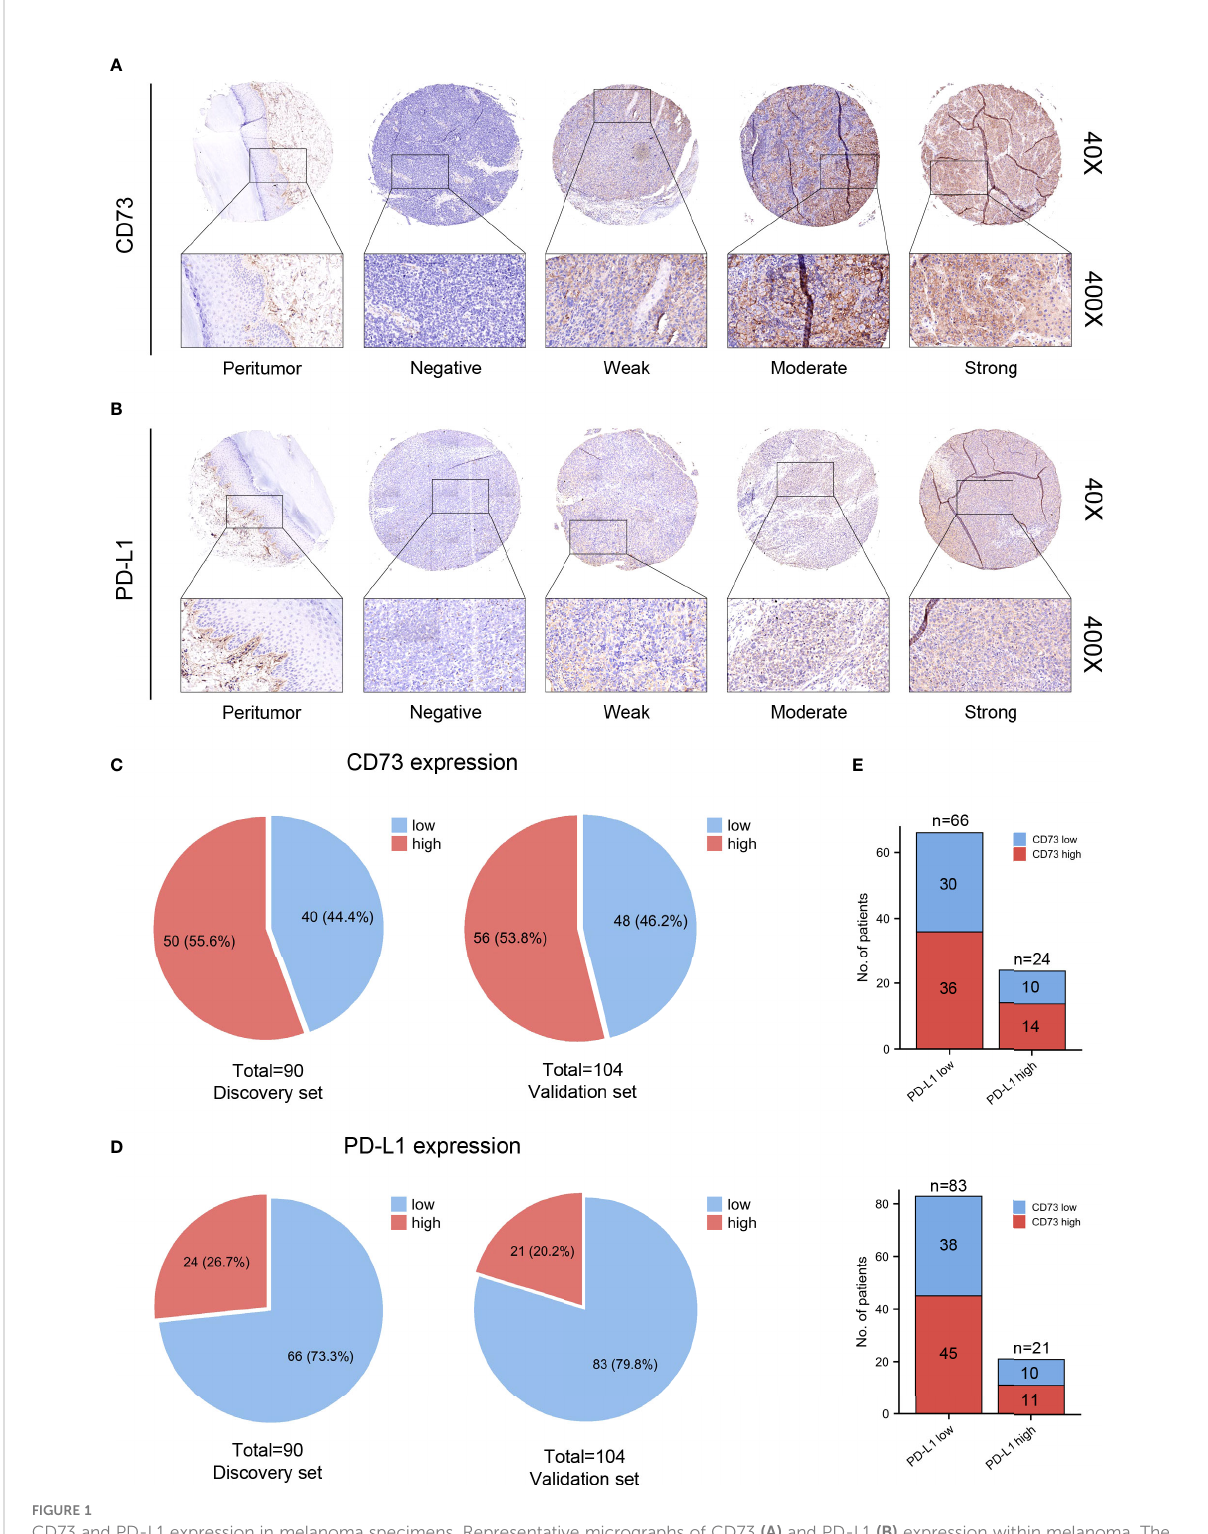
FIGURE 1 CD73 and PD-L1 expression in melanoma specimens. Representative micrographs of CD73 (A) and PD-L1 (B) expression within melanoma. The positive rate of CD73 in discovery and validation sets were 55.6 and 53.8% respectively (C) . PD-L1 was elevated in 26.7 and 20.2% of cases in discovery and validation sets, respectively (D) . No signi fi cant correlation was found between CD73 and PD-L1 expression (E)